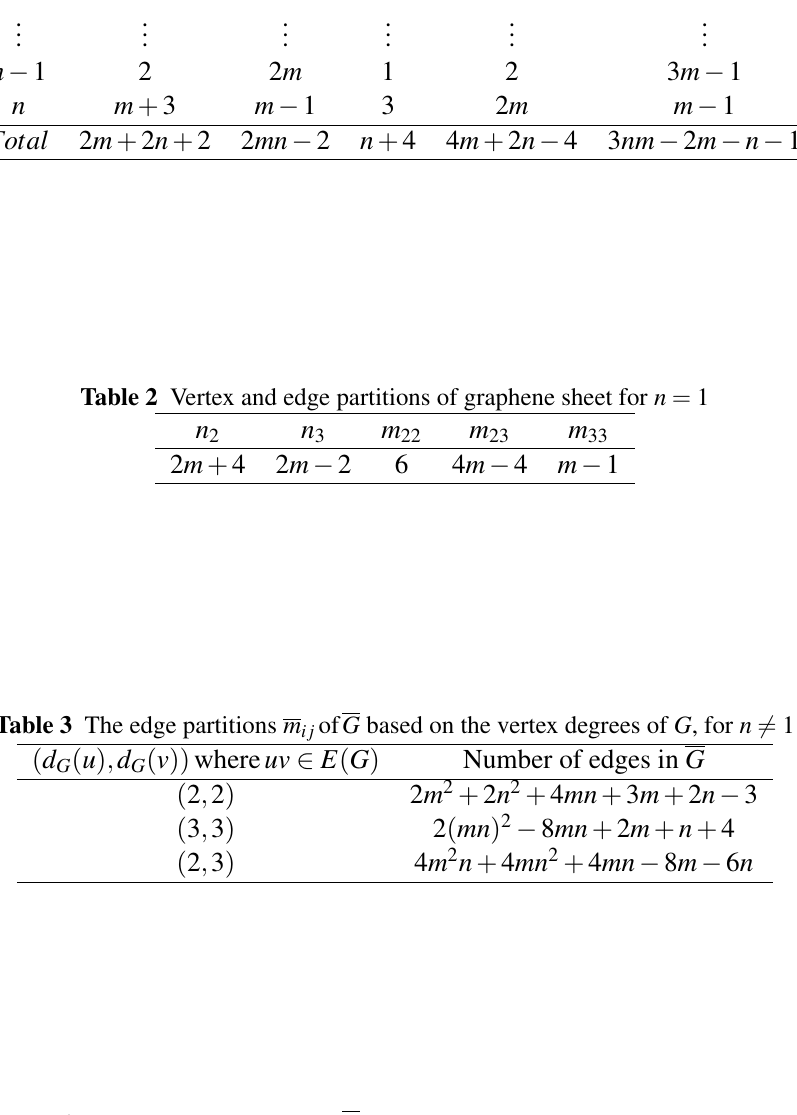
Table 4 The edge partitions m ij of G based on the vertex degrees of G , for n = 1 ( d G ( u ) , d G ( v )) where uv ∈ E ( G